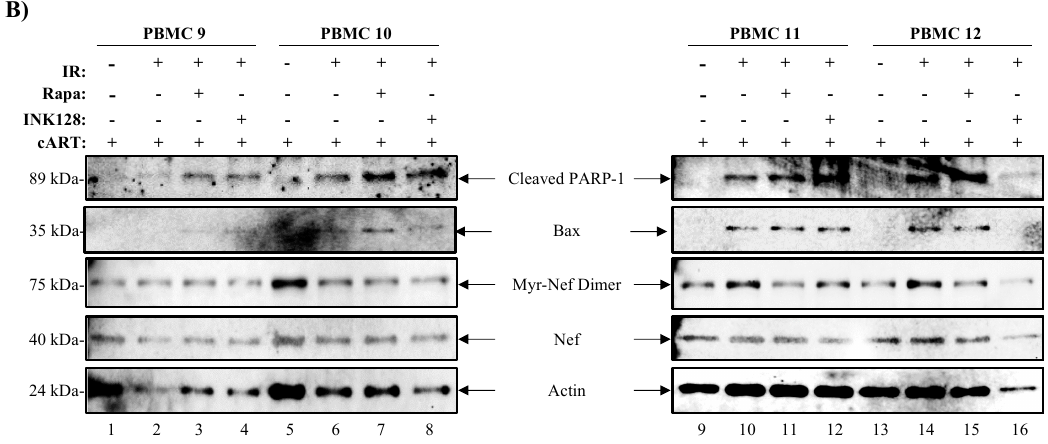
Figure 6. mTORi drugs mitigate the effects of EV-TNF- α and viral proteins on recipient cells. ( A ) Nanotraped EVs (100 µL; NT80/82) from four PBMCs treated with control (untreated), IR (10 Gy), IR/Rapa (10 Gy/300 nM), and IR/INK128 (10 Gy/300 nM) were cultured with HLM-1 recipient cells which contain a triple mutation in Tat and transcription can be induced by IR and TNF- α . Western Blot analysis was used to detect the presence of viral proteins (i.e., p24, gp120, gp41), EVs marker (i.e., CD63), cytokine (i.e., mTNF- α and TNF- α ), and actin. ( B ) Cell pellets from PBMCs 9–12 infected with HIV-1 89.6 were treated with IR (0.5 Gy), Rapa (50 nM) or INK128 (50 nM), and 3% FBS media for 5 days prior to Western Blot analysis for markers of cell death (i.e., PARP-1 and Bax) and virus (i.e., Nef).